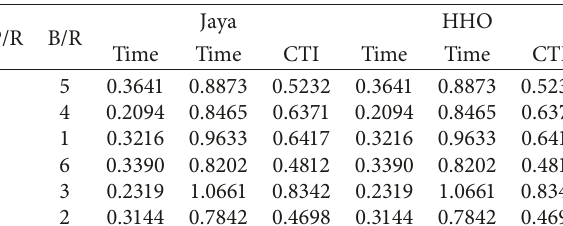
Table 3: Operating time and CTI for the 3-bus system by LP formulation.